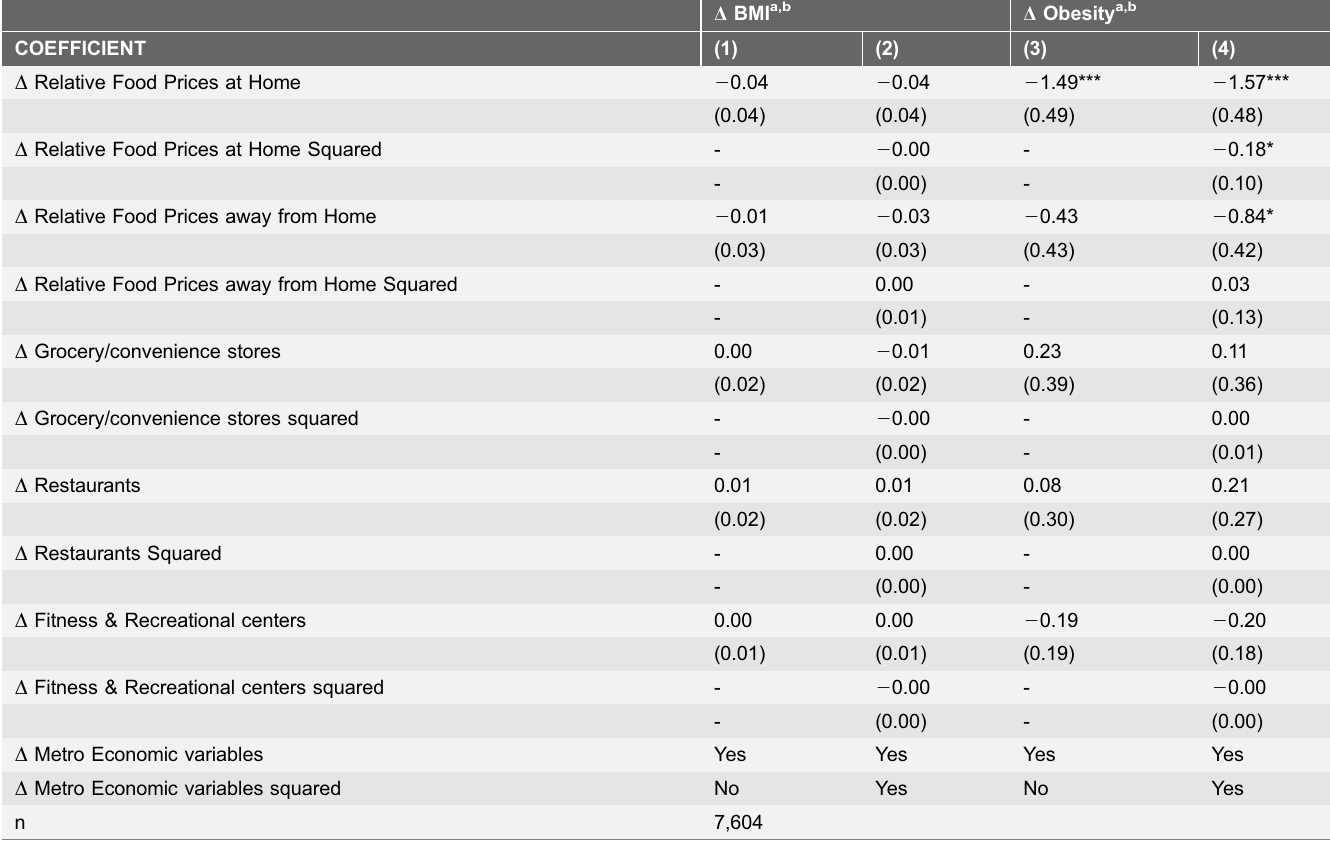
Table 5. The Estimated Effects of Relative Food Price Changes on BMI and Obesity: The